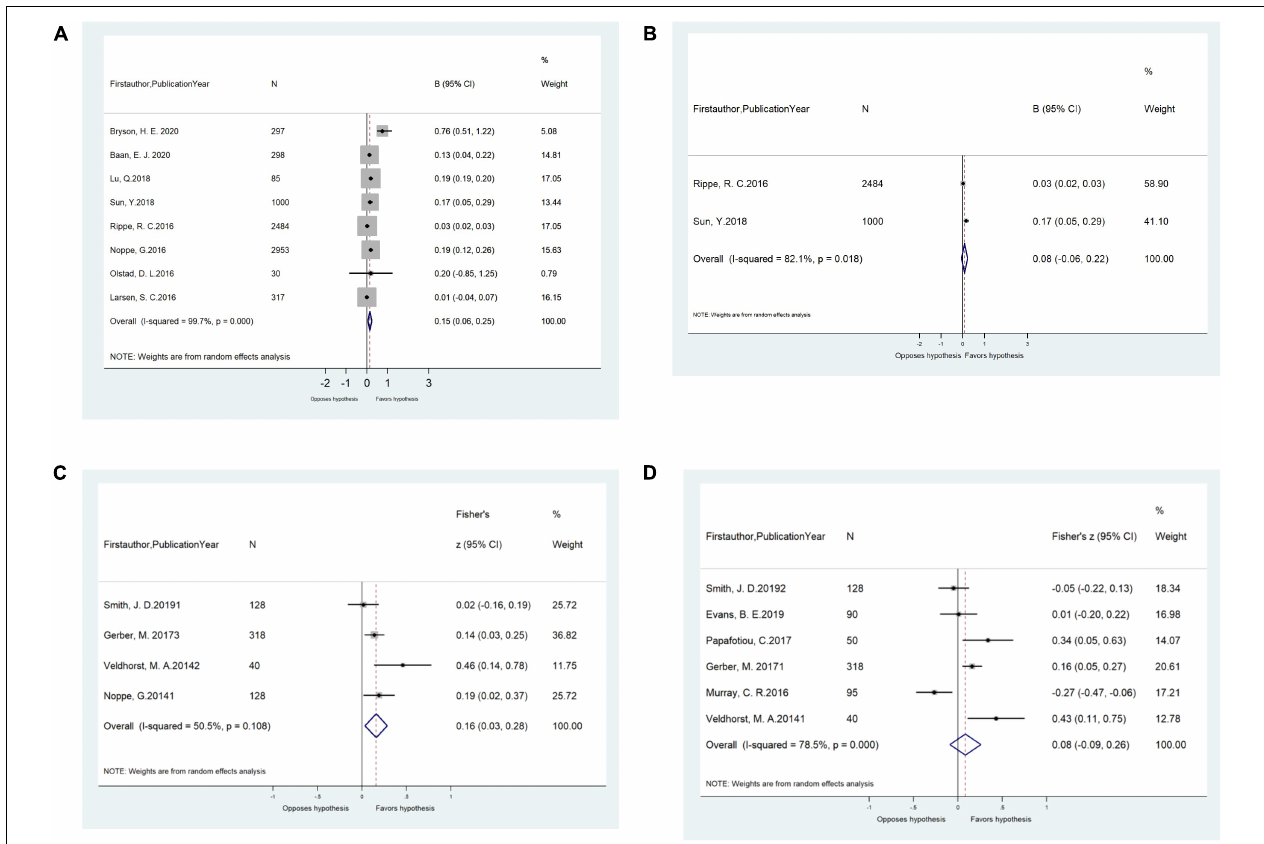
FIGURE 2 | (A) Meta-analysis of the adjusted associations ( β , 95% CI) between hair cortisol and BMI/BMI z-score in cross-sectional studies ( n = 8). (B) Meta-analysis of the adjusted associations ( β , 95% CI) between hair cortisol and FMI-SDS/FMI z-score in cross-sectional studies ( n = 2). (C) Meta-analysis of the unadjusted correlations ( r , 95% CI) between hair cortisol and waist circumference in cross-sectional studies ( n = 4). (D) Meta-analysis of the unadjusted correlations ( r , 95% CI) between hair cortisol and BMI/BMI z-score/BMI-SDS in cross-sectional studies ( n = 6). BMI, body mass index; BMI SDS, BMI standard deviation